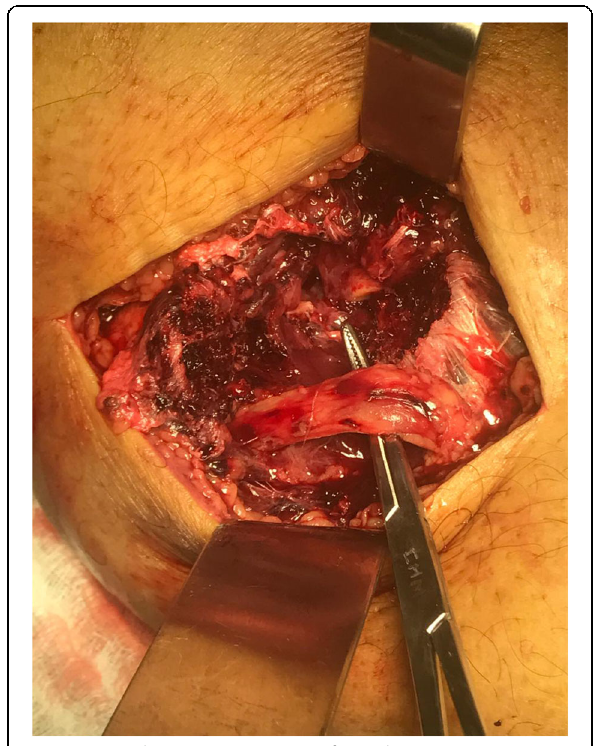
Fig. 3 Peroneal Contusion. Courtesy of Ricardo Garcia